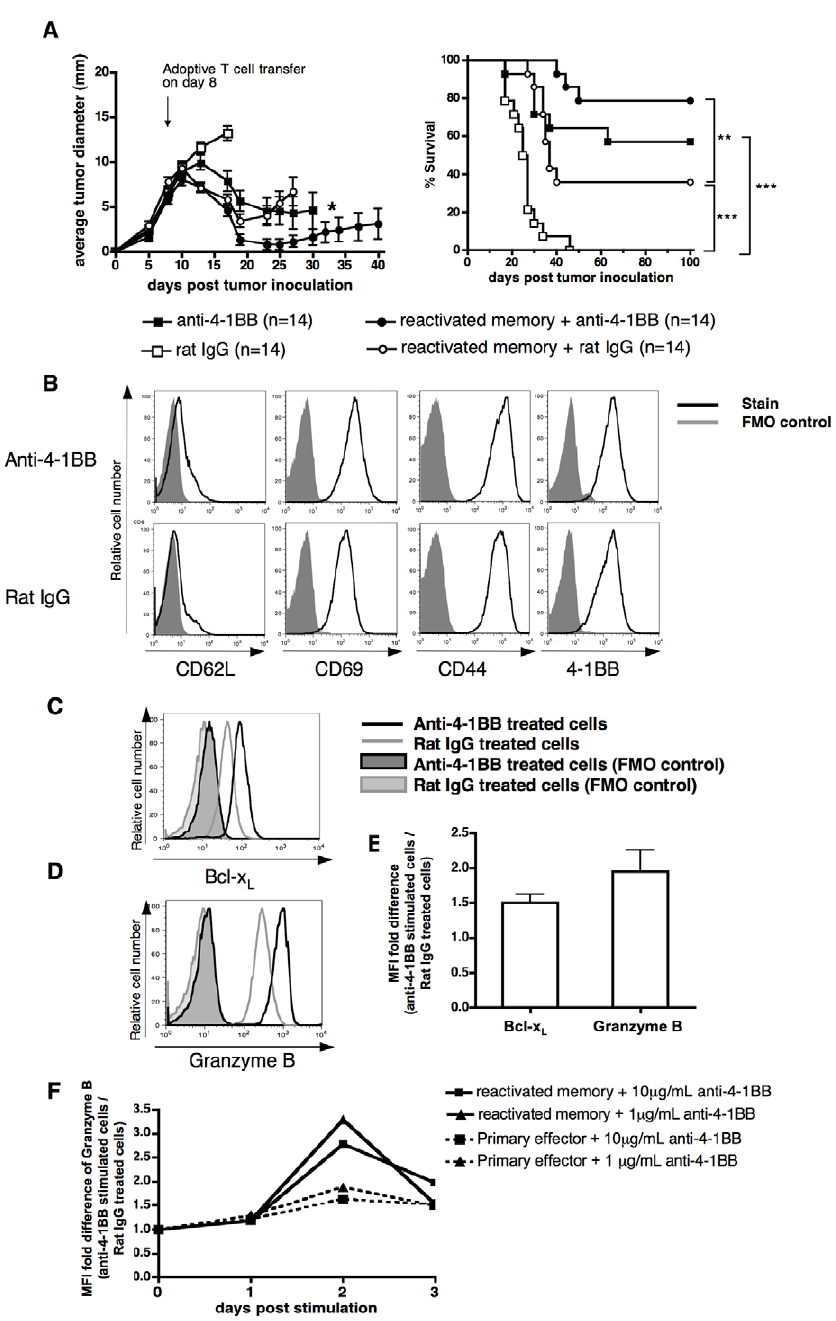
Figure 4. Combination immunotherapy with agonistic anti-4-1BB antibody and reactivated memory CD8 T cells. (A) C57BL/6 mice were inoculated s.c. with E.G7 tumor cells on day 0. On day 8, adoptive transfer was performed by injecting 3 6 10 6 reactivated memory OT-I cells i.v. into tumor bearing mice. The agonistic anti-4-1BB antibody (3H3, 100 m g per mouse) was administrated by i.p. injection immediately following T cell adoptive transfer and repeated once 3 days later. Average tumor growth, the number (n) of mice per group and survival of tumor bearing mice are shown. Results are pooled from two independent experiments. (* Tumor growth curve discontinued at the time when the first animal in the group succumbed to the disease, except for the anti-4-1BB antibody treated group in which one tumor bearer was sacrificed on day 18). Survival curves were analyzed by the LogRank test, with **P , 0.01 and ***P , 0.001 . (B–E) Resting memory T cells, prepared as in Figure 1, were reactivated with peptide in the presence of 10 m g/mL of rat IgG or anti-4-1BB agonist for two days. Expression levels of the activation markers (B), Bcl-x L (C) and granzyme B (D) were analyzed. Representative histograms from one of the two independent experiments are shown. (E) Summary of the enhancement of Bcl-x L and granzyme B from two experiments. Median fluorescence intensity (MFI) fold differences are calculated as follows: [(MFI of the staining of anti-4-1BB stimulated cells/MFI of the FMO of anti-4-1BB stimulated cells)]/[(MFI of the stain of the rat IgG treated cells/MFI of the FMO of the rat IgG treated cells)]. (F) Resting memory OT-I T cells, in parallel with purified naı¨ve OT-I CD8 T cells, were activated with peptide pulsed splenocytes in the presence of 1 m g/mL or 10 m g/mL of rat IgG or anti-4-1BB agonist. Kinetics of the induction of granzyme B is shown. Median fluorescence intensity (MFI) fold differences were calculated as in figure 4E.